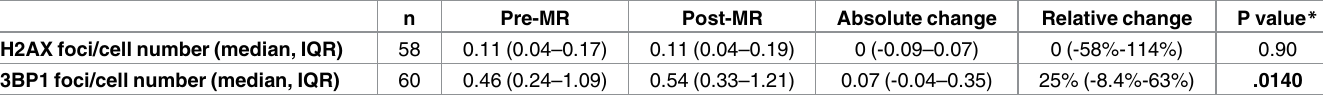
Table 2. Changes in H2AX and 53BP1foci per cell following cardiac MR